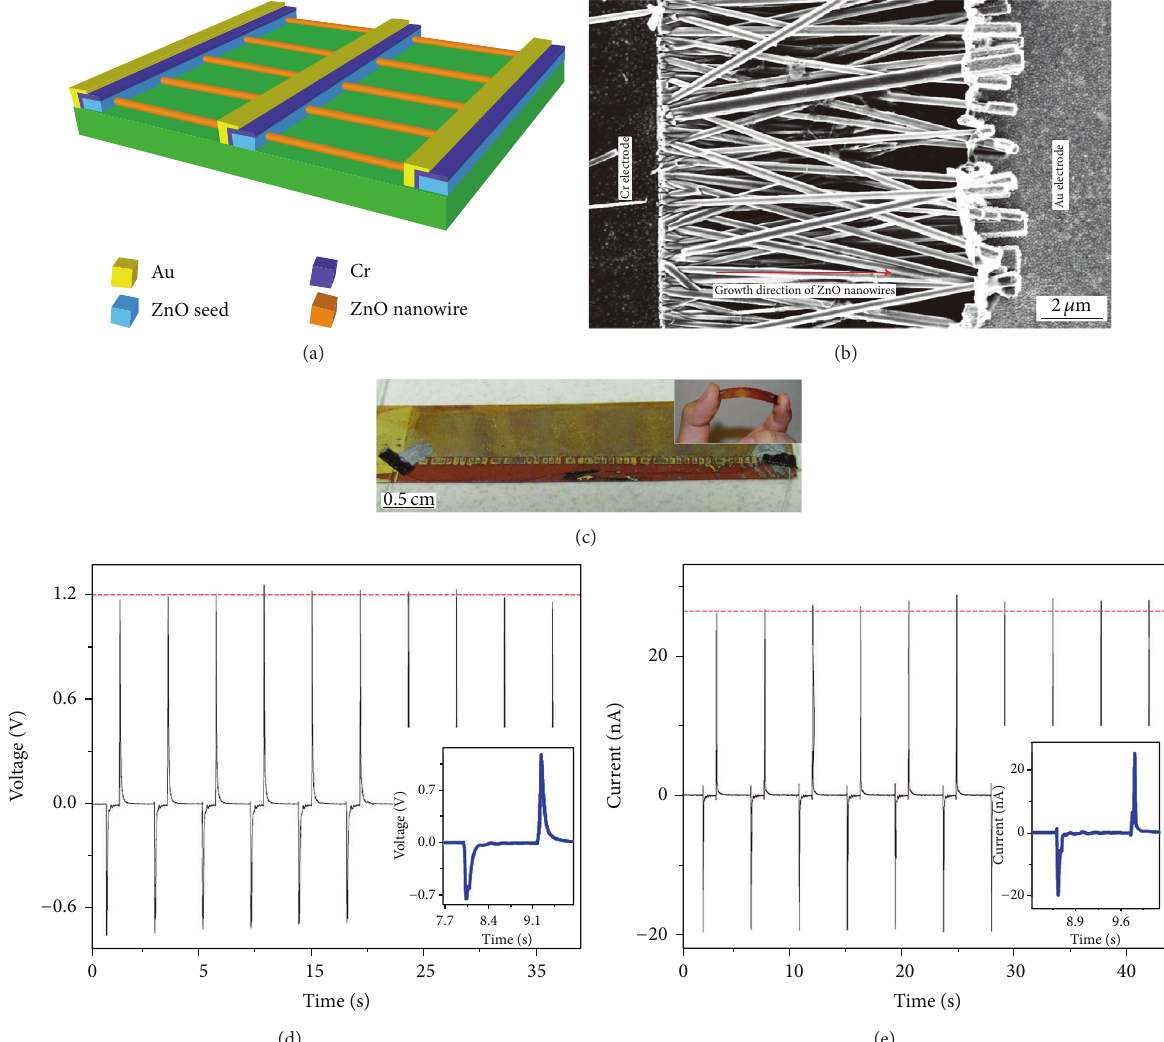
Figure 9: The structural characterization and output performance of the ZnO LINGs. (a) Schematic diagram. (b) Local SEM image; (c) Photograph of a packaged device. (d) Output open-circuit voltage. (e) Output short-circuit current. (Reproduced from [42] with the permission from Nature Publishing